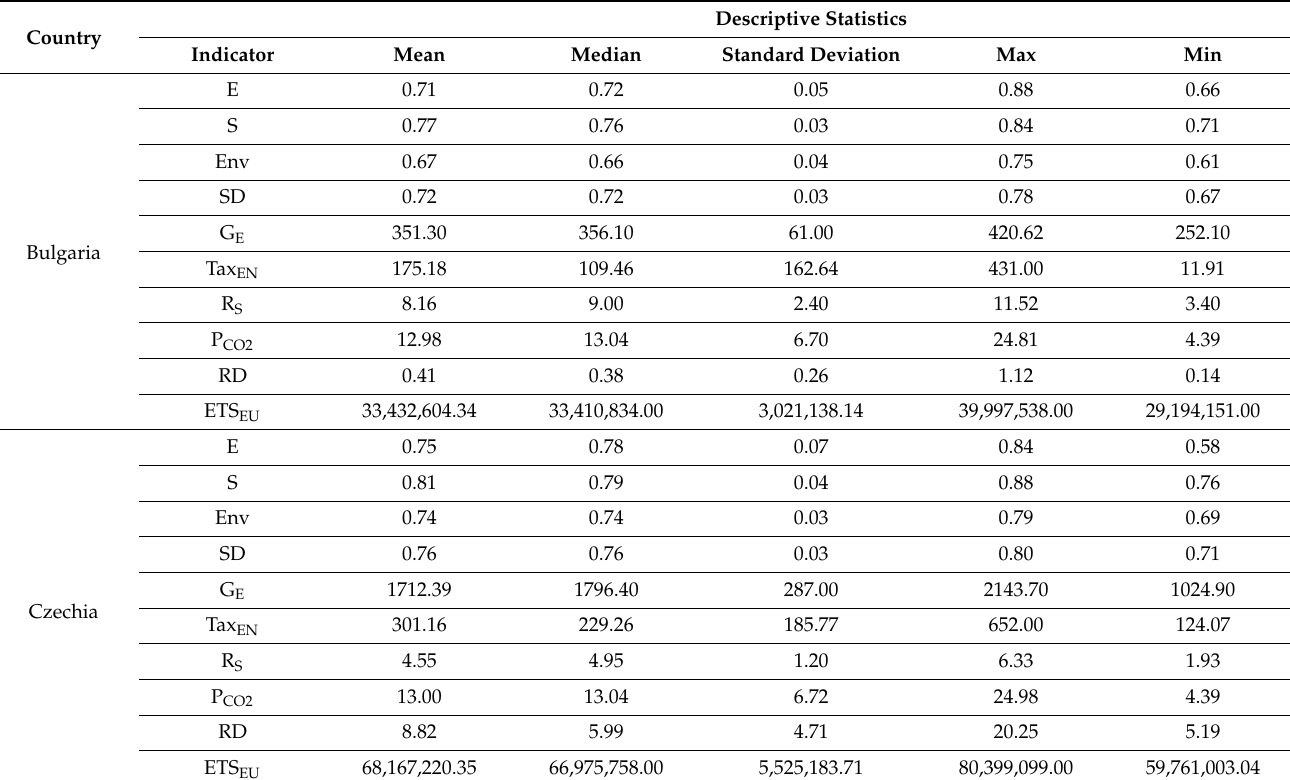
Figure 2. Selected energy economy factors in the analyzed countries from 2008 to 2022 (dotted line is a trend line of the indicators: trend line). Source: own elaboration. Table 1 presents descriptive statistics of the sustainable development of the energy sector (and its pillars) and selected energy economy factors in Bulgaria, Czechia, Estonia, and Poland from 2008 to 2022. Table 1. Descriptive statistics of sustainable development of energy sector (and its pillars) and se- lected energy economy factors in the analyzed countries from 2008 to 2022. Country